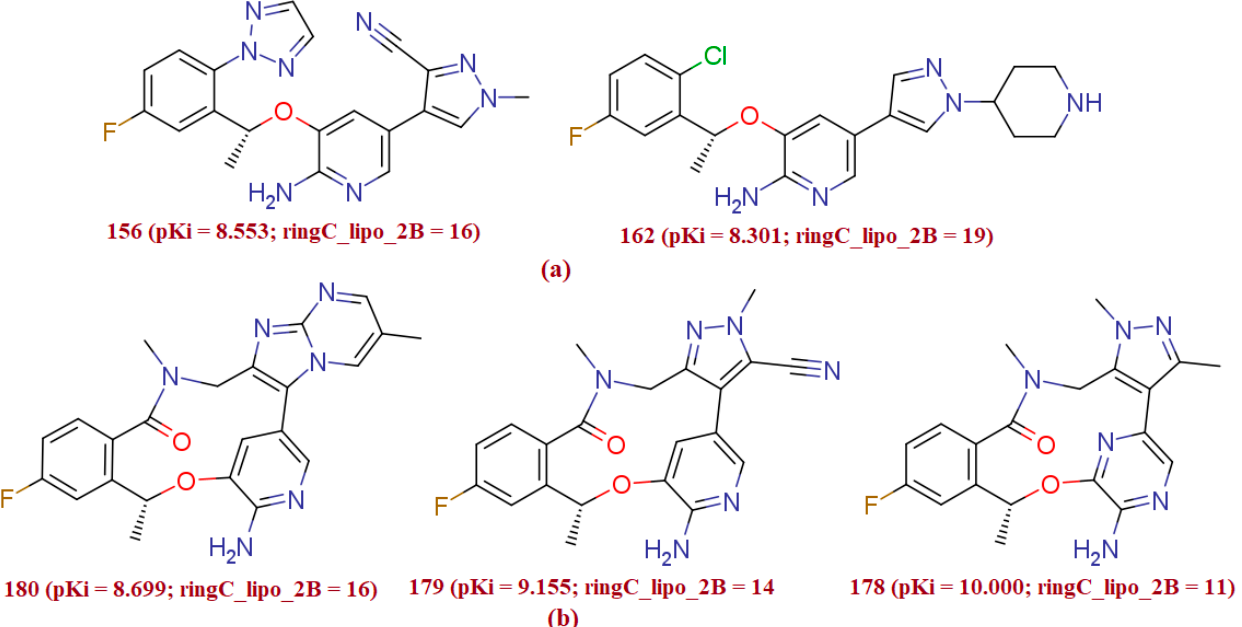
Figure 6. Presentation of the molecular descriptor ringC_lipo_2B for the molecular pair 156 and 162 ( a ) and for another molecular pair; 180, 179 and 178 ( b ) only (the ring carbon atoms within 2 bonds from the lipophilic carbon atoms are highlighted by blue ball).